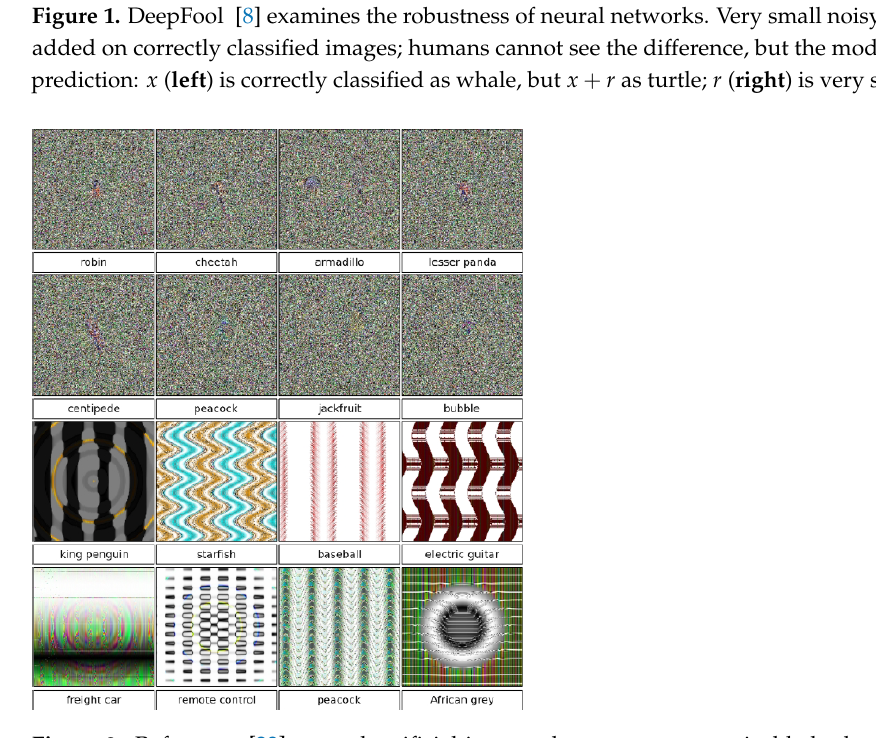
Figure 2. Reference [23] created artificial images that were unrecognizable by humans, but the state-of-the-art classifier was very confident that they were known objects. Images are either directly ( top ) or indirectly ( bottom ) encoded.